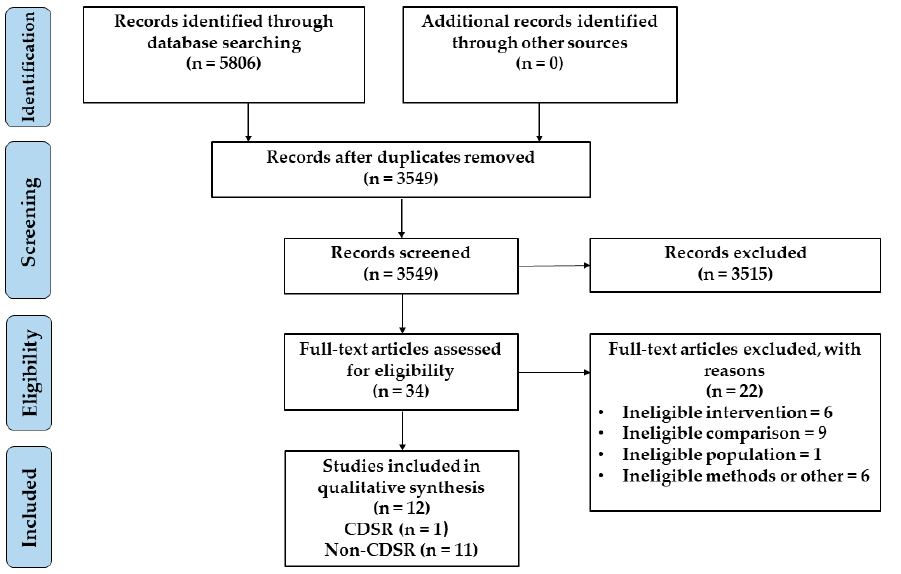
Figure 1. Flowchart of the study selection